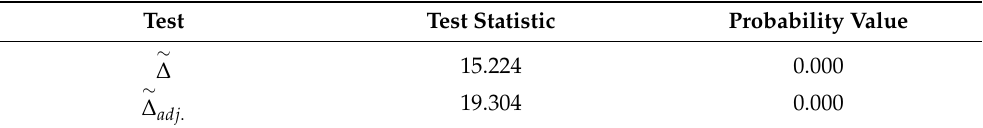
Table 5. Homogeneity tests’ results.